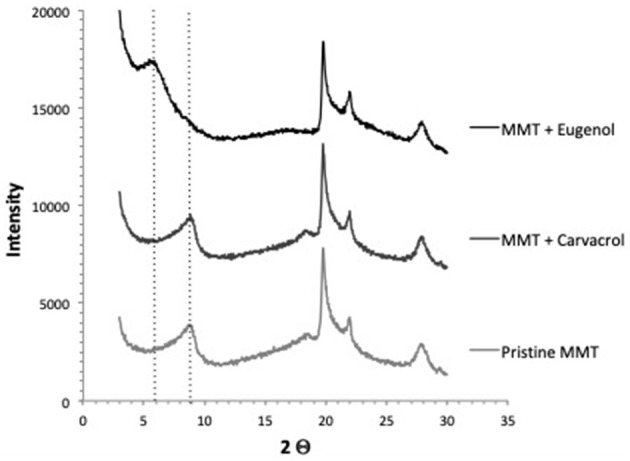
XRD patterns of nanoclays powder (Na+-MMT) mixed with eugenol or carvacrol.